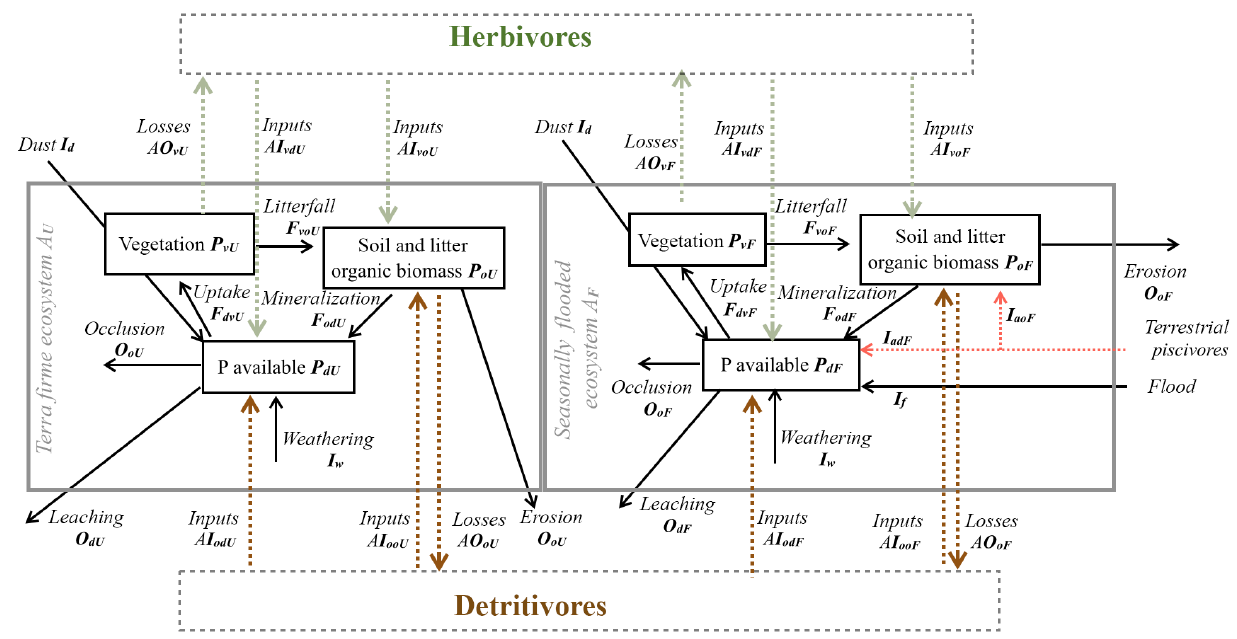
Figure 3. Model structure diagram representing the redistribution of P due to herbivory and detritivory. Diagram of model structure repre- senting P fluxes and pools. Black arrows represent the P fluxes among pools representing the basin dynamics of the P cycle and color arrows represent the P fluxes due to animal consumption and dual habitat use: green arrows for herbivory fluxes and brown arrows for detritivory fluxes; red arrow for terrestrial